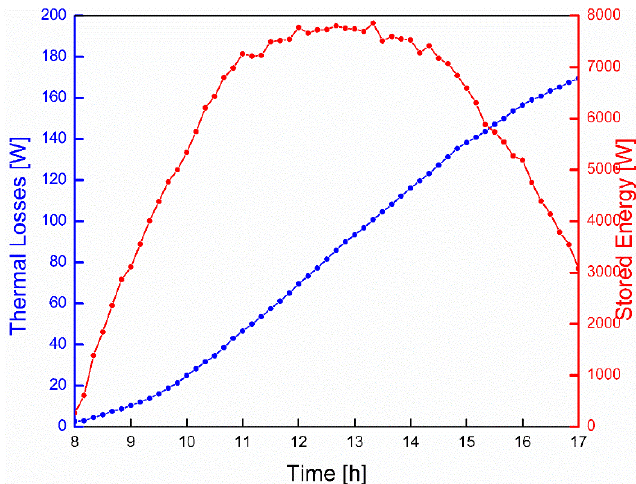
Figure 7. Variation of thermal losses and stored energy in the intermediate buffer.